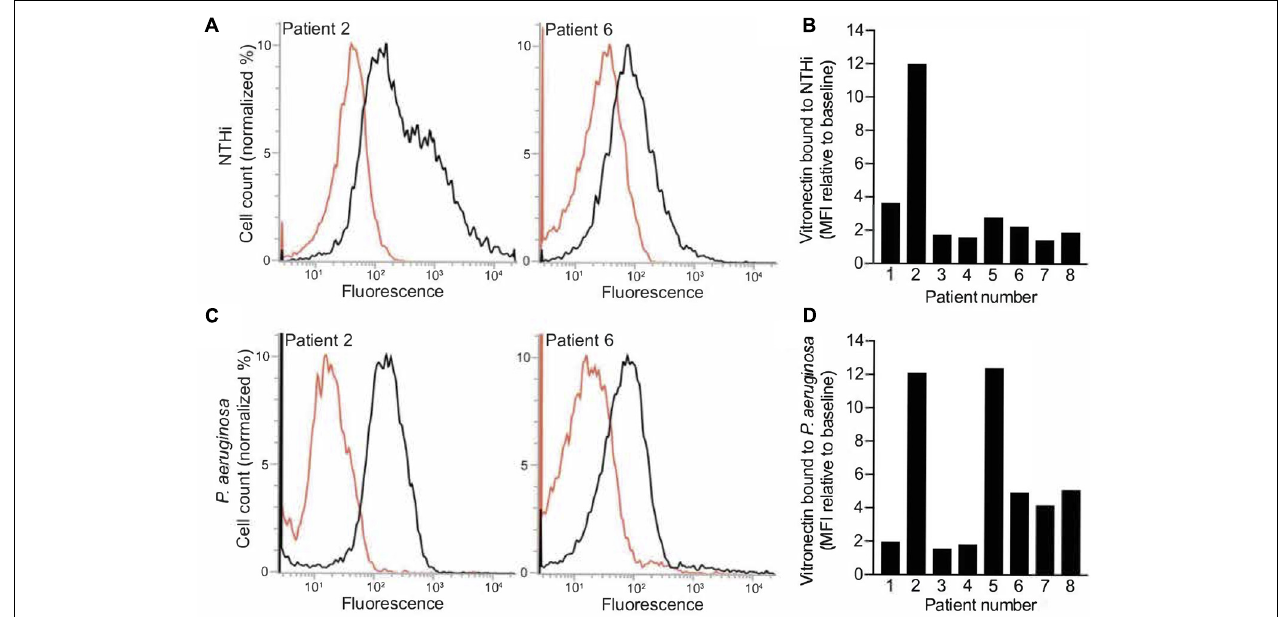
FIGURE 3 | Bacterial respiratory pathogens capture vitronectin from BALF. Binding of vitronectin by nontypeable H. influenzae (NTHi) 3655 (A,B) and P. aeruginosa KR796 (C,D) incubated in BALF from pneumonia patients was determined by flow cytometry using primary anti-vitronectin and secondary fluorescent antibodies. Control samples were incubated with secondary antibodies only. (A,C) Histograms of two experiments, representing BALF from different patients, for each bacterial species are shown. Control samples are indicated in red. (B,D) The change in fluorescence intensity of test relative to control samples reveals that bacteria bound vitronectin in all patient BALF samples. Bars represent mean values of two biological replicates.